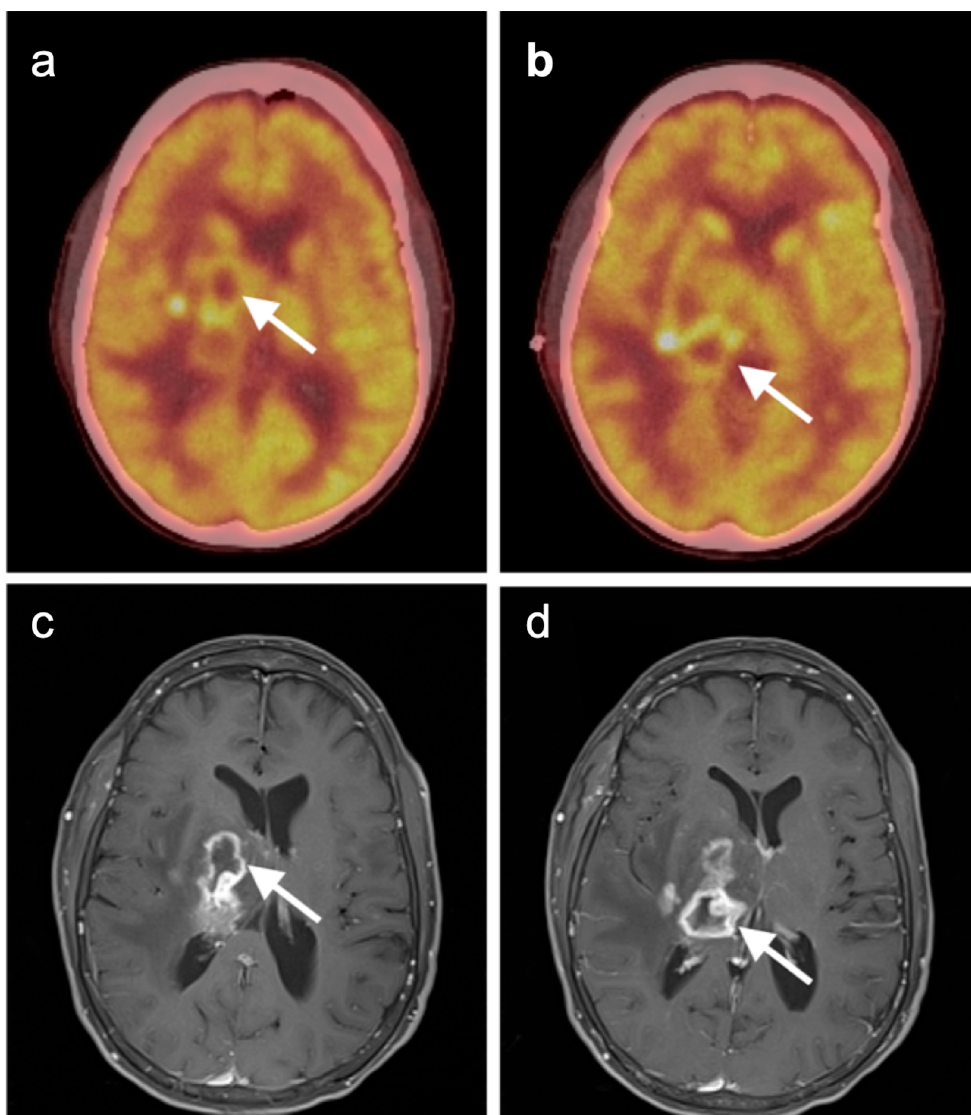
Figure 41. Diffuse large B-cell lymphoma. ( a – d ) Findings on MRI in an immunocompromised patient raise the question of infection (such as toxoplasmosis) versus CNS tumor, particularly lymphoma. ( a , b ) Multiple lesions are peripherally hypermetabolic on axial FDG PET-CT (white arrows) and were biopsy-proven to be DLBCL ( c , d ) Gd-enhanced fat saturation axial T1 MRI images show multiple ring ‐ enhancing lesions (white arrows).